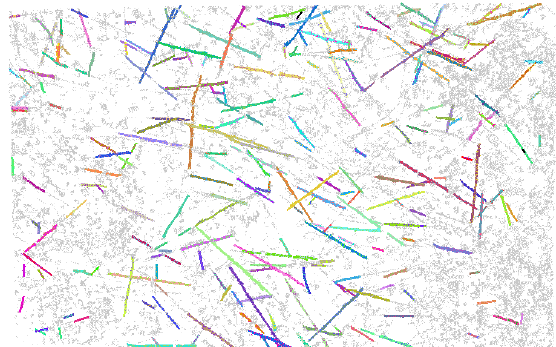
Figure 7: Segmentation result - Plot A.